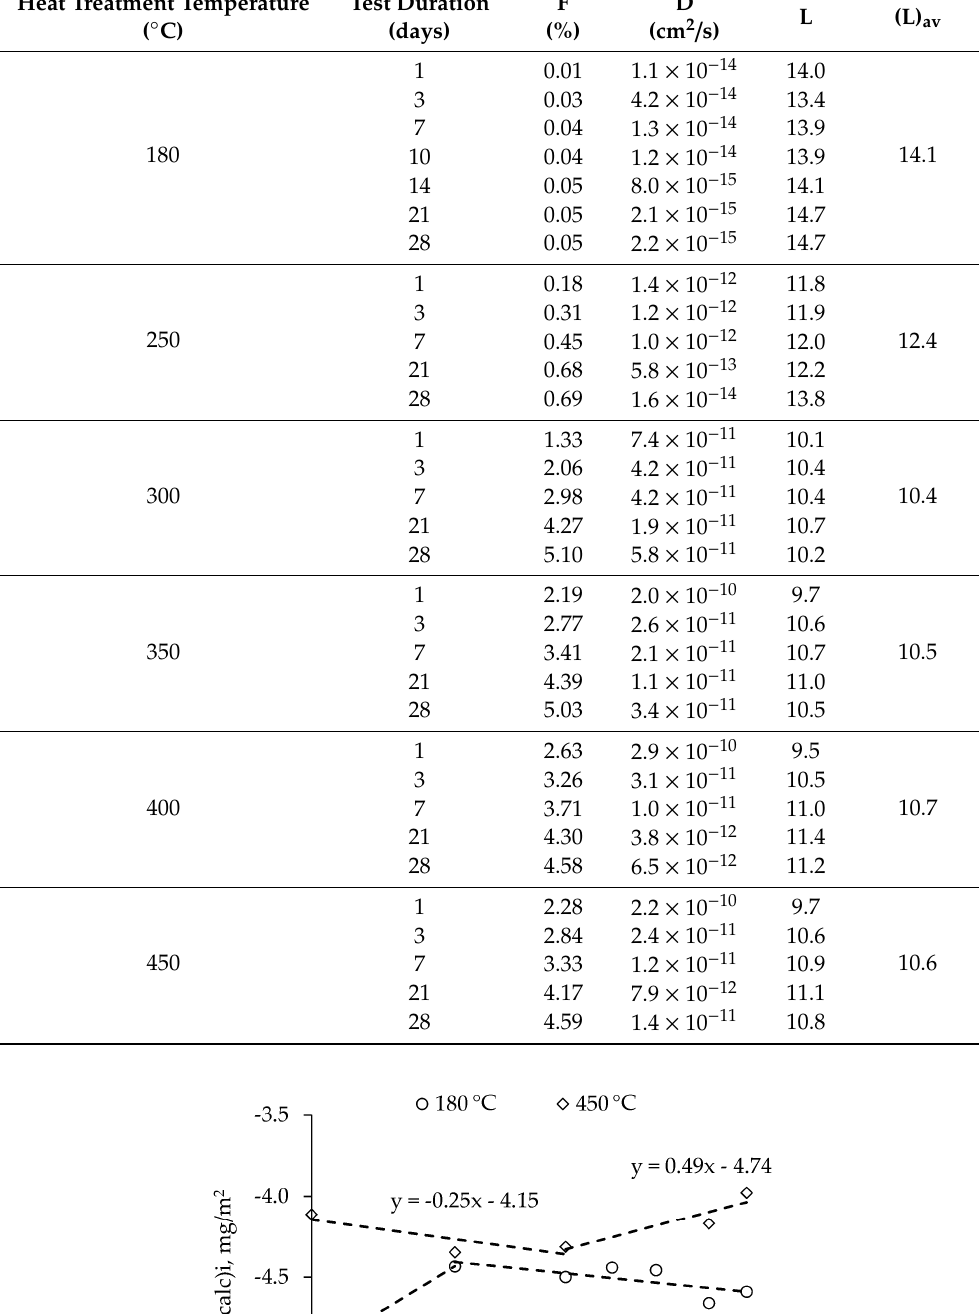
Table 3. Leaching data of 137 Cs from MPP-FKN-W compound.